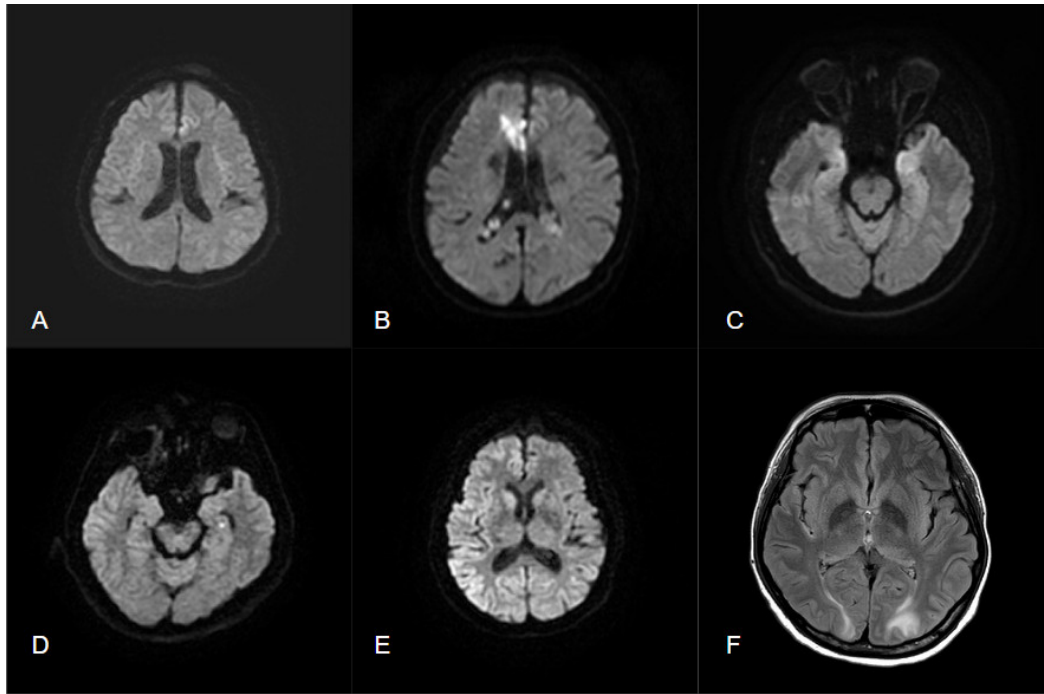
Figure 3. ( A ) Status epilepticus presents a left frontal cortical hyperintensity in DWI; ( B ) acute ischemic infarction in right ACA territory with DWI hyperintensity; ( C ) autoimmune encephalitis presents with bilateral hyperintensity in DWI and T2 FLAIR; ( D ) dot-like hyperintensity of DWI in TGA; ( E ) diffuse gyriform hyperintensity of DWI in cerebral cortex in sCJD; ( F ) bilateral hyperintensity of T2 FLAIR in white matter regions without abnormalities in DWI in PRES.